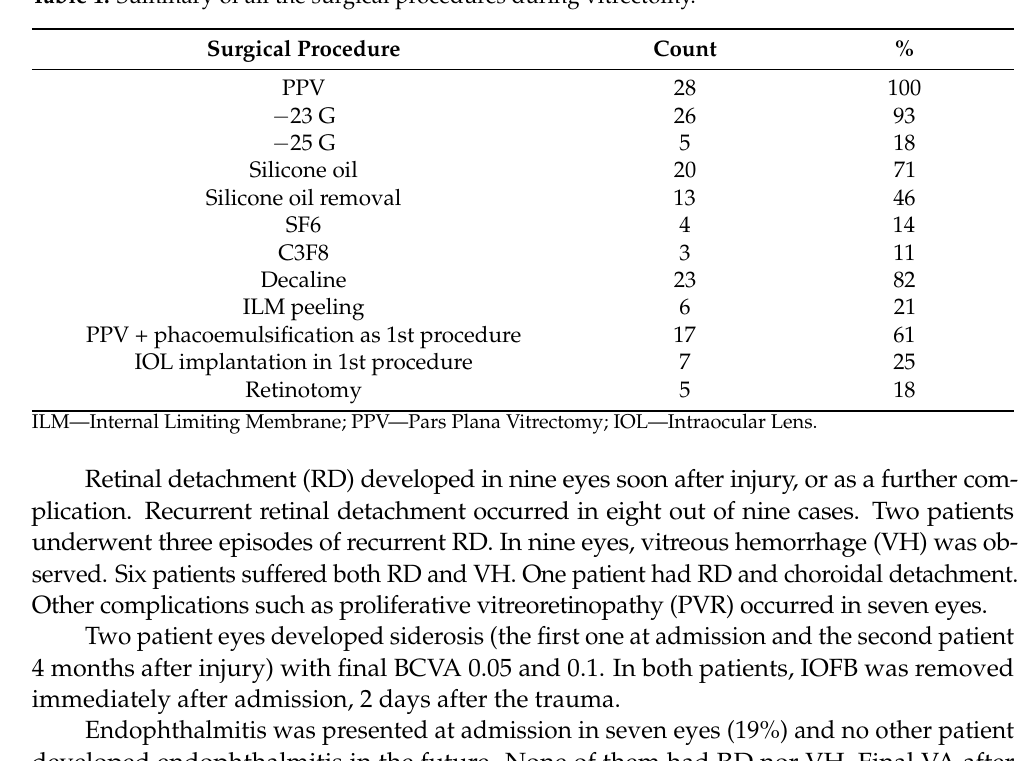
Table 1. Summary of all the surgical procedures during vitrectomy.